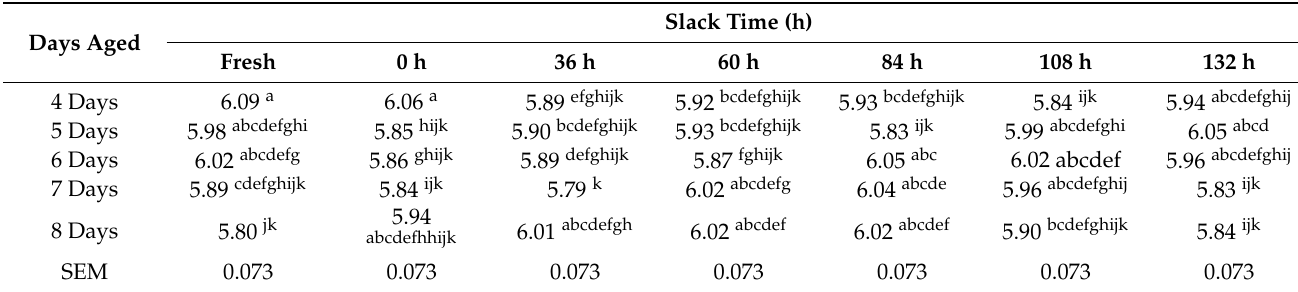
Table 4. Interactive impact (days aged 1 × slack time 2 ) on pH 3 of the chicken tenderloins during simulated food service shelf-life.